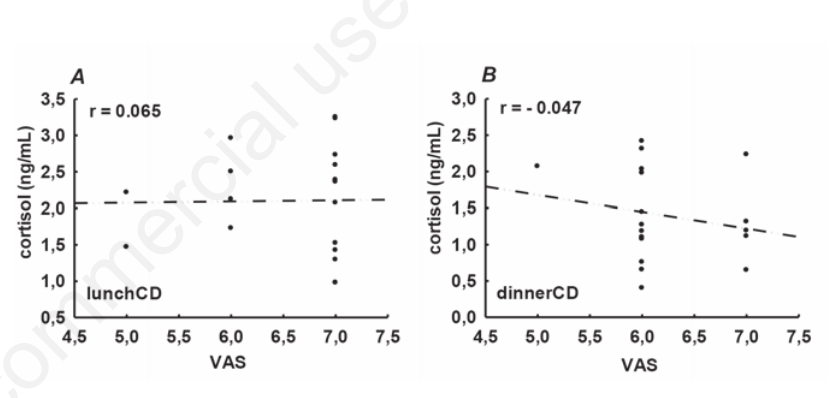
Figure 1. Spearman correlation between salivary cortisol and Visual Analogue Scale (VAS) after (A) lunchCD and after (B) dinnerCD; n=18 in each group. The r values for the linear correlation are in the top of the